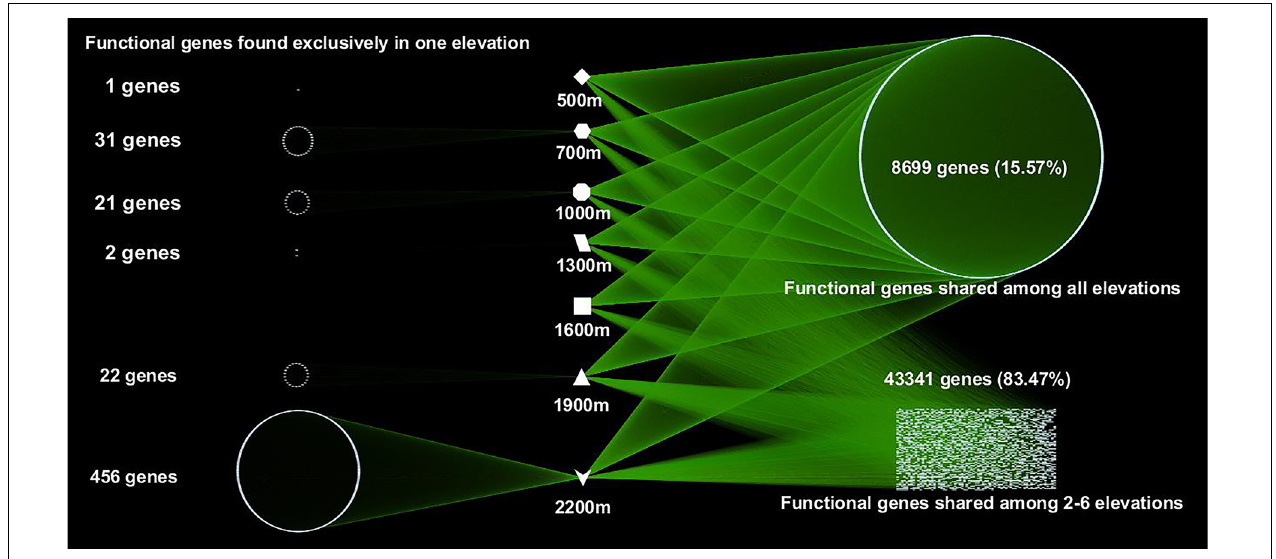
FIGURE 1 | A network map showing the interactions of microbial functional genes among all the samples from different elevations. Each point represents one independent functional gene. Functional genes in the left column were unique to one site, while those in the right belonged to multiple elevation sites.